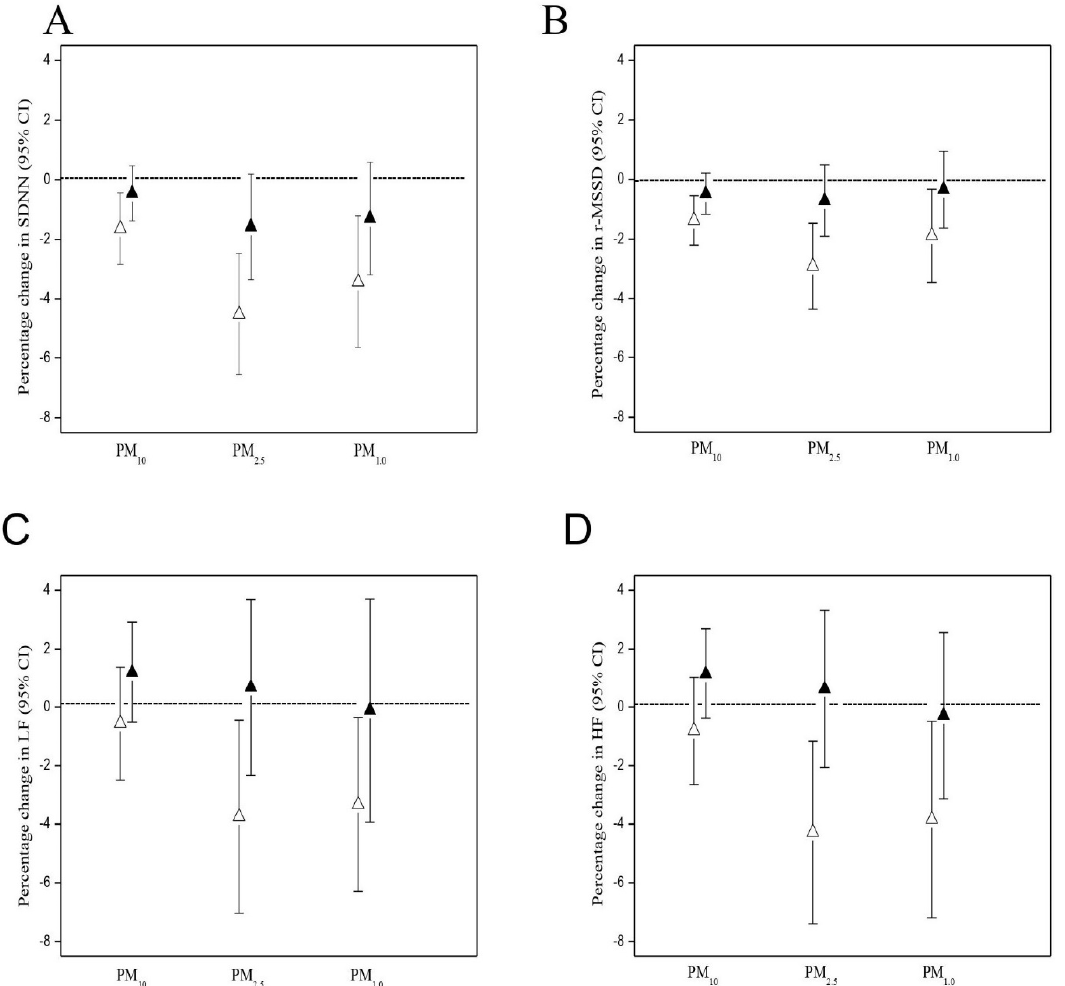
Figure 1. Comparisons of effects of 1-h moving average PM exposure on heart rate variability (HRV) among 54 workers with (solid triangles) and without (open triangles) adjustment of heart rate as estimated using linear mixed effects models. ( A ) Effects of 1-h moving average PM exposure on SDNN, ( B ) Effects of 1-h moving average PM exposure on r-MSDD, ( C ) Effects of 1-h moving average PM exposure on LF, ( D ) Effects of 1-h moving average PM exposure on HF. Models were adjusted for age, BMI, smoking, years as a cook, and ambient temperature.